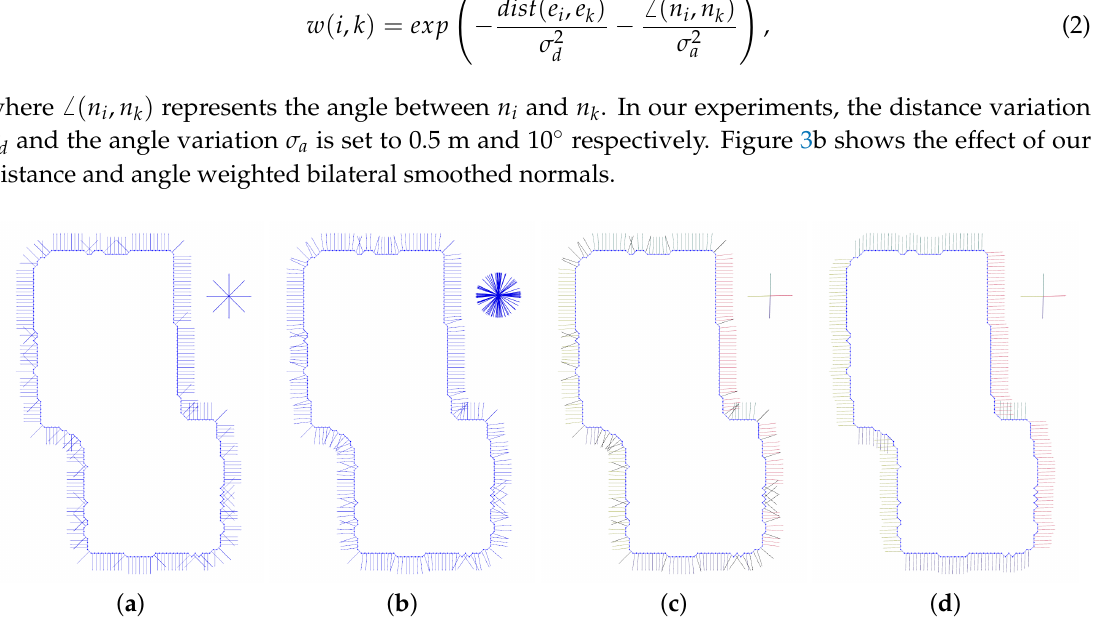
Figure 3. Dominant directions detection and alignment direction. ( a ) initial normals orthogonal to the edges have limited variation due to rasterization. ( b ) bilaterally smoothed ( thre d = 0.5 m) normals capture the dominant directions in Section 2.2. ( c ) detected four dominant directions (outliers in black) using RANSAC in Section 2.2. ( d ) find the target alignment direction for each edge with the MRF formulation in Section